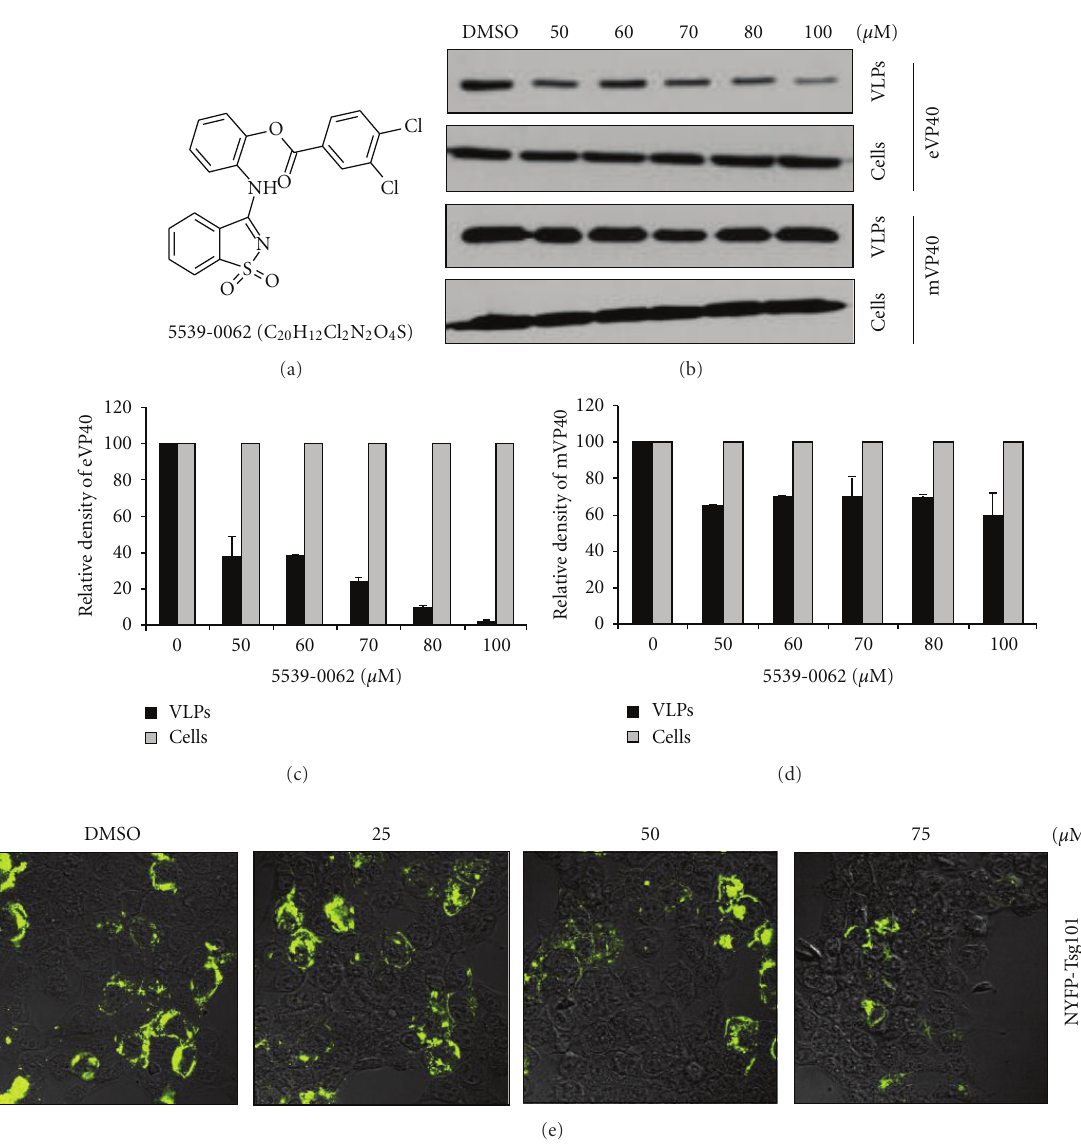
Figure 4: Inhibition of VP40-Tsg101 interactions and VLP budding. (a) Chemical structure of compound 5539-0062. (b) Budding assay and western blotting for eVP40 and mVP40 in VLPs and cell extracts from human 293T cells treated with DMSO alone, or the indicated concentrations of PTAP-inhibitor 5539-0062. (c) Bar graph of the relative amounts of eVP40-WT in cells and VLPs (part B) determined using Dot-Blot, LabWorks software (UVP). (d) Bar graph of the relative amounts of mVP40-WT in cells and VLPs (part B) determined using Dot-Blot, LabWorks software (UVP). (e) BiMC of human 293T cells expressing NYFP-Tsg101 + CYFP-eVP40-WT and treated with DMSO alone, or the indicated concentrations of PTAP-inhibitor 5539-0062. Cells were examined for YFP fluorescence at 24 hour p.t., and positive cells were quantified by FACS analysis. The average values were as follows: DMSO alone = 100%, 25 µ M = 84%, 50 µ M = 68%, and 75 µ M = 24%.